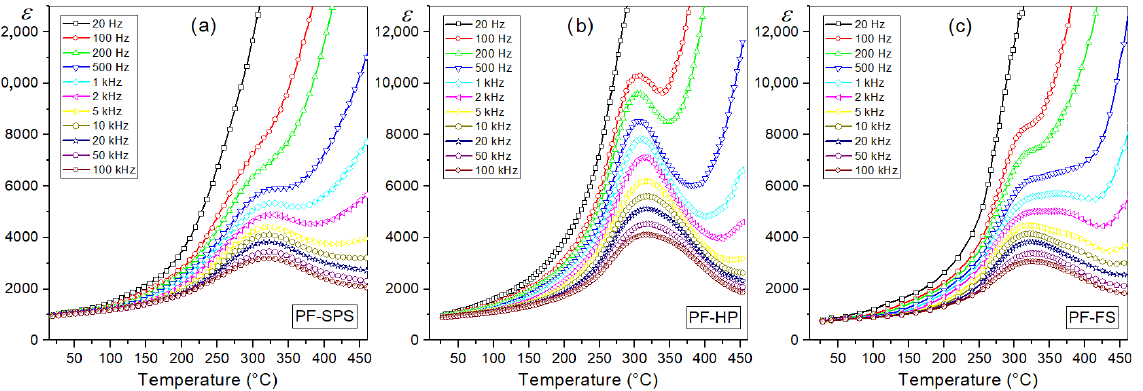
Figure 8. Temperature dependencies of permittivity for the PF multiferroic composites (heating): PF-SPS ( a ), PF-HP ( b ), and PF-FS ( c ). PF-SPS ( a ), PF-HP ( b ), and PF-FS ( c ).